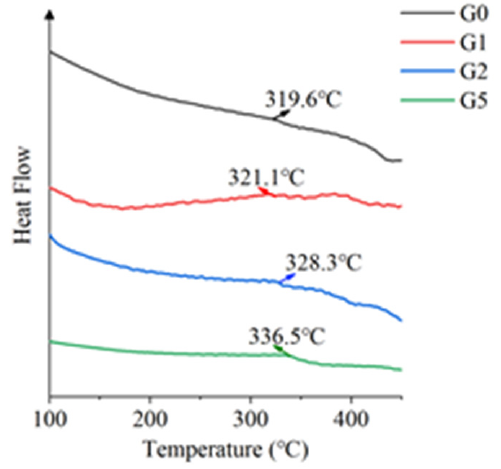
Figure 10. Secondary heating curve.